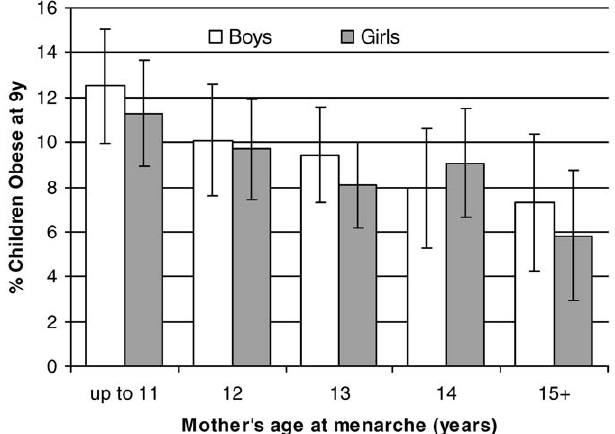
Figure 1. Prevalence of Obesity in Children at Age 9 y, by Mother’s Age at Menarche Data are proportions ( 6 95% CI) of children with obesity (BMI . 97th percentile according to the UK 1990 growth reference [19]) in each quintile of mother’s menarche from the whole ALSPAC cohort (boys: p - value for trend ¼ 0.003, n ¼ 2,961; girls: p -value for trend ¼ 0.006, n ¼ 3,048), adjusted for age, mother’s education, and also for mother’s BMI.